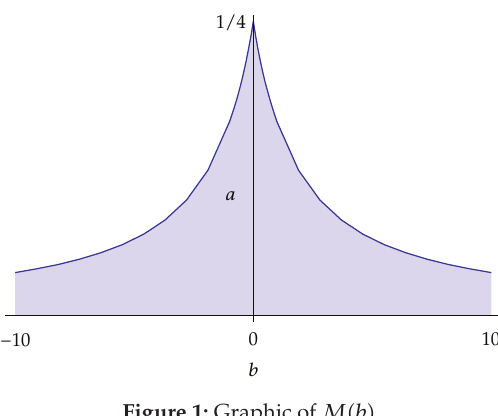
Figure 1: Graphic of M (cid:2) b (cid:3)